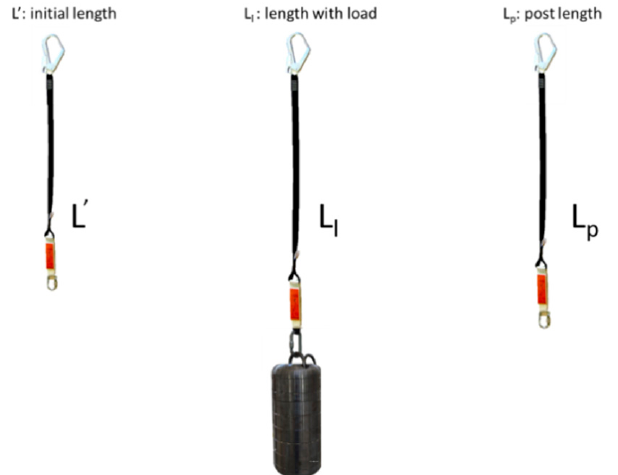
Figure 4. Measured lengths.